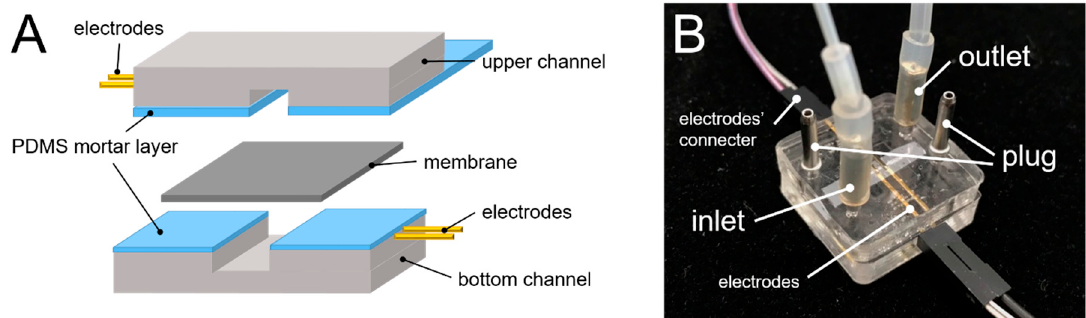
Figure 2. The fabrication of the microchip. ( A ) schematic of electrodes (protruding structures) with the membrane placed between the channels and ( B ) photograph of the integrated system.